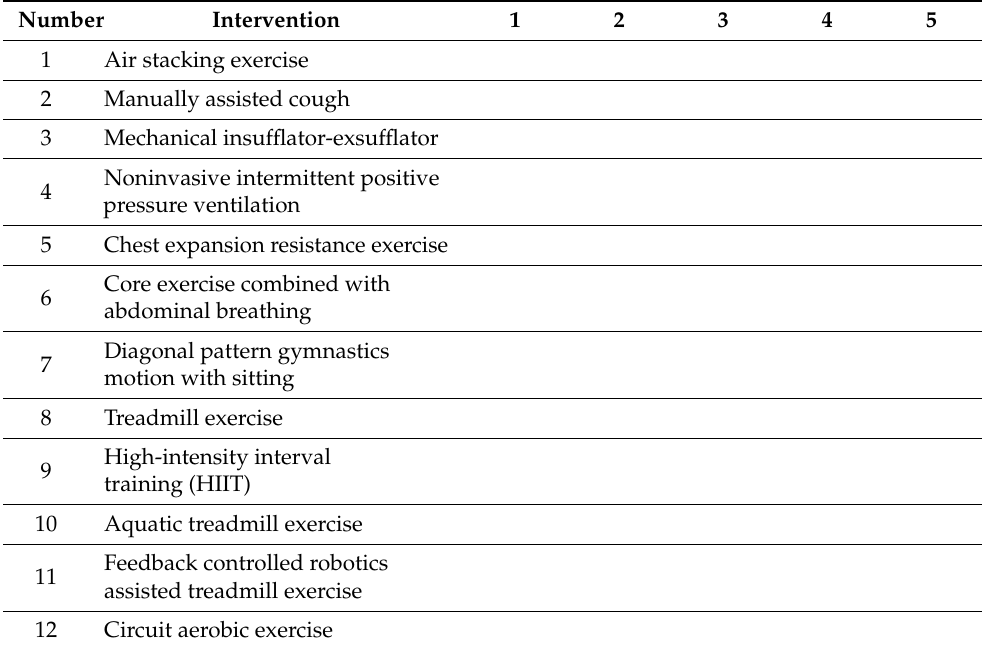
Table A1. Cardiorespiratory fitness interventions for stroke patients (first modified Delphi technique). Please select the appropriate answer for each